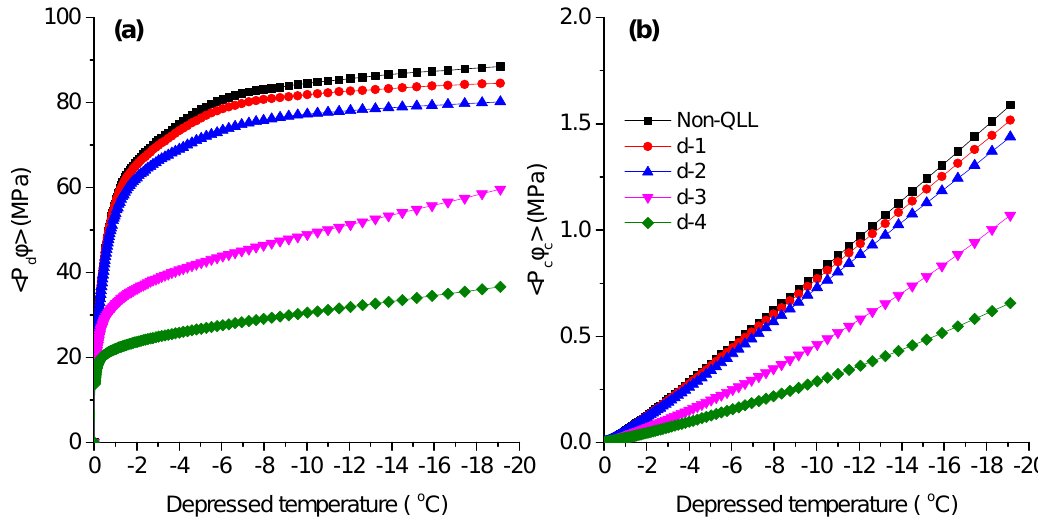
Figure 5. ( a ) Hydraulic pressures of confined freezing induced by the density change and ( b ) crystallization pressures induced by the curvature effect during freezing with different models of QLL